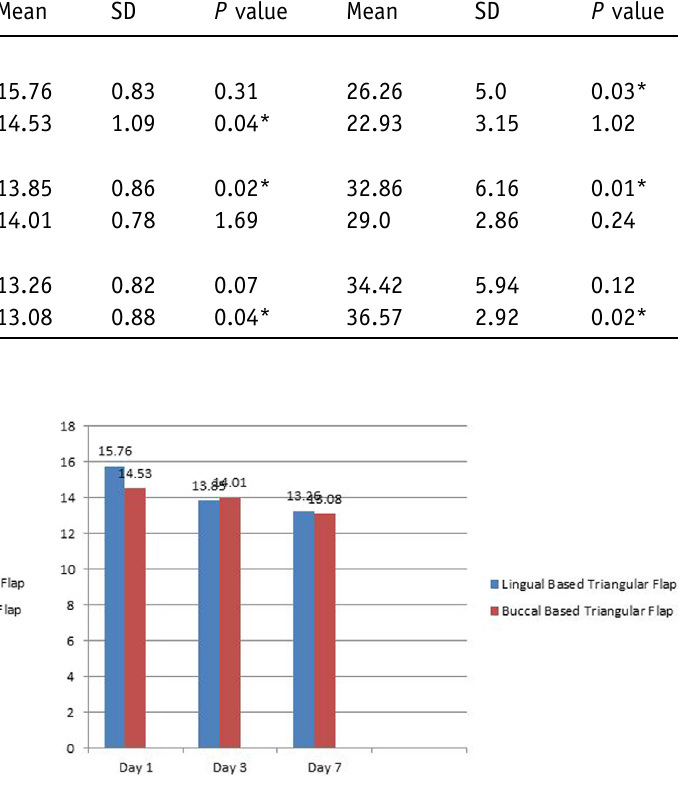
Fig. 7. The average scores for swelling (mm) between buccal based triangular fl ap and lingual based triangular fl ap.